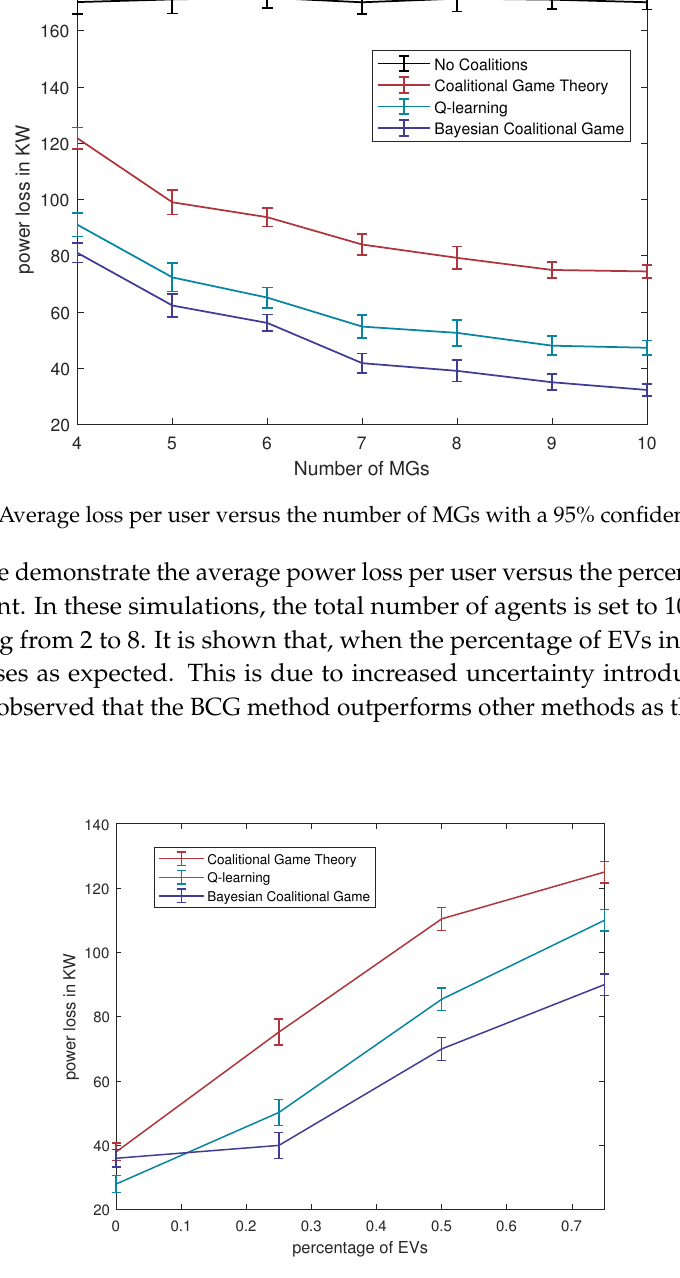
Figure 3. Average loss per user versus the percentage of EVs with a 95% confidence